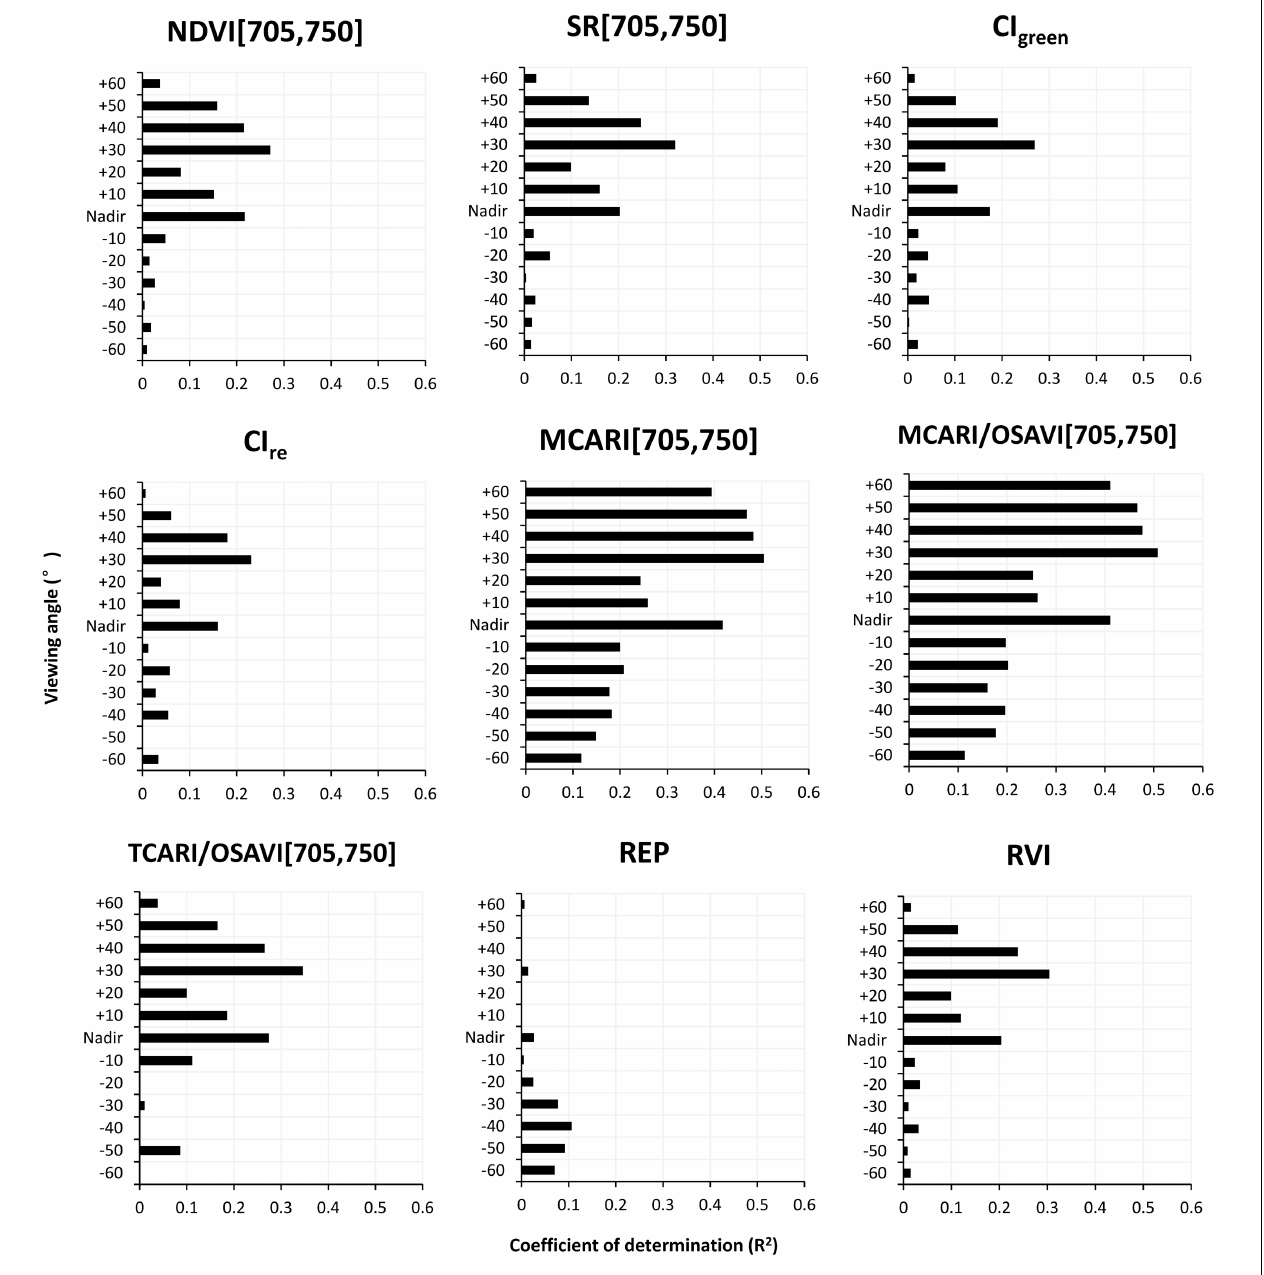
FIGURE 7 | The R 2 of relationship between better performing VIs (shown in Figure 4 ) and field measured canopy chlorophyll content at different viewing angles.